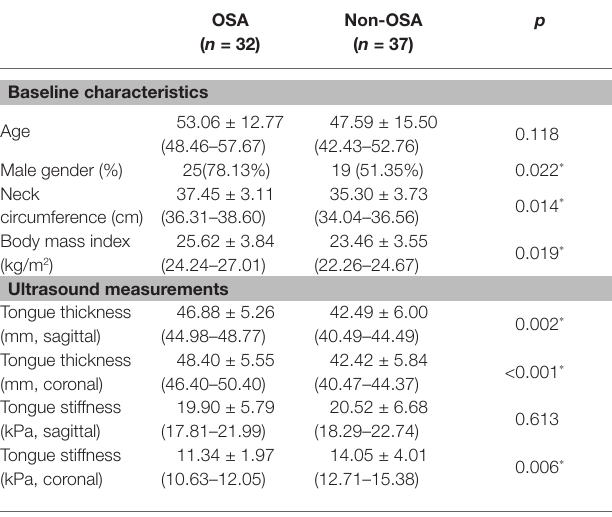
TABLE 1 | Basic characteristics and ultrasound measurement of tongue in participants with or without obstructive sleep apnea